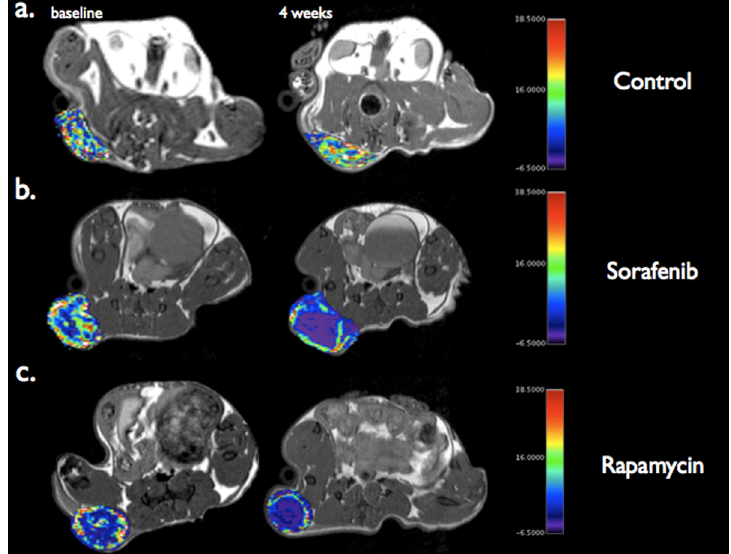
Figure 3. T1-weighted MRI of mice with pseudocolorized VVF maps superimposed over the center of the tumor within the right flank for each treatment arm (control ( a ), sorafenib ( b ), and Rapamycin ( c )) of the trial at baseline, and at the end of therapy.